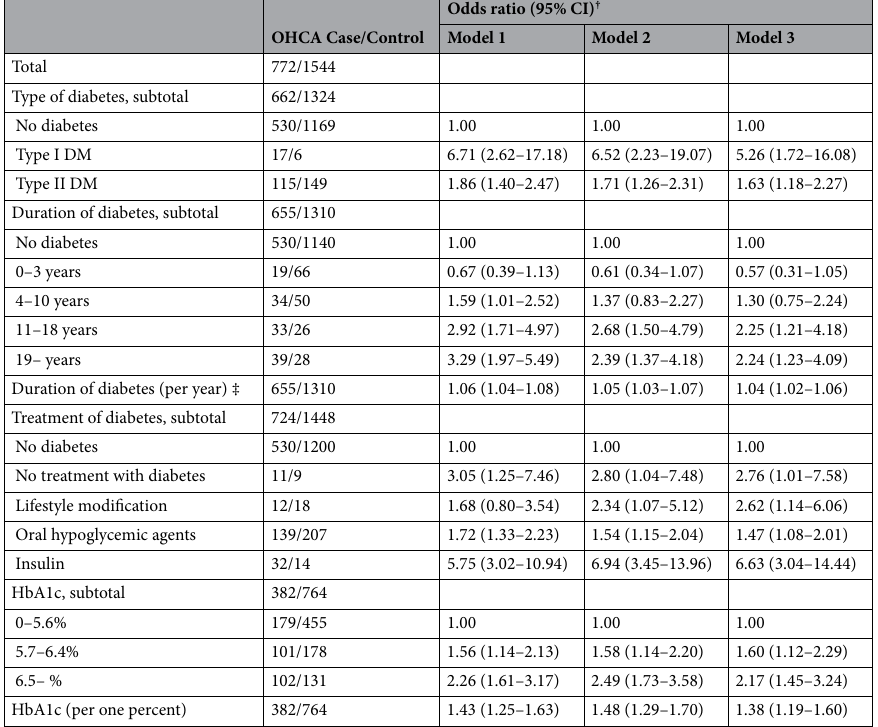
Table 3. Risk of characteristics of diabetes mellitus for out-of-hospital cardiac arrest among the study population. CI, confidence interval; DM, diabetes mellitus; HbA1c, hemoglobin A1c. Model 1: Unadjusted conditional logistic regression. Model 2: Conditional logistic regression adjusted for comorbidities (hypertension, myocardial infarction, stroke, dyslipidemia, and arrhythmia) . Model 3: Conditional logistic regression adjusted for comorbidities (hypertension, myocardial infarction, stroke, dyslipidemia, and arrhythmia) and health behaviors (current smoking status, obesity, and regular exercise during the last